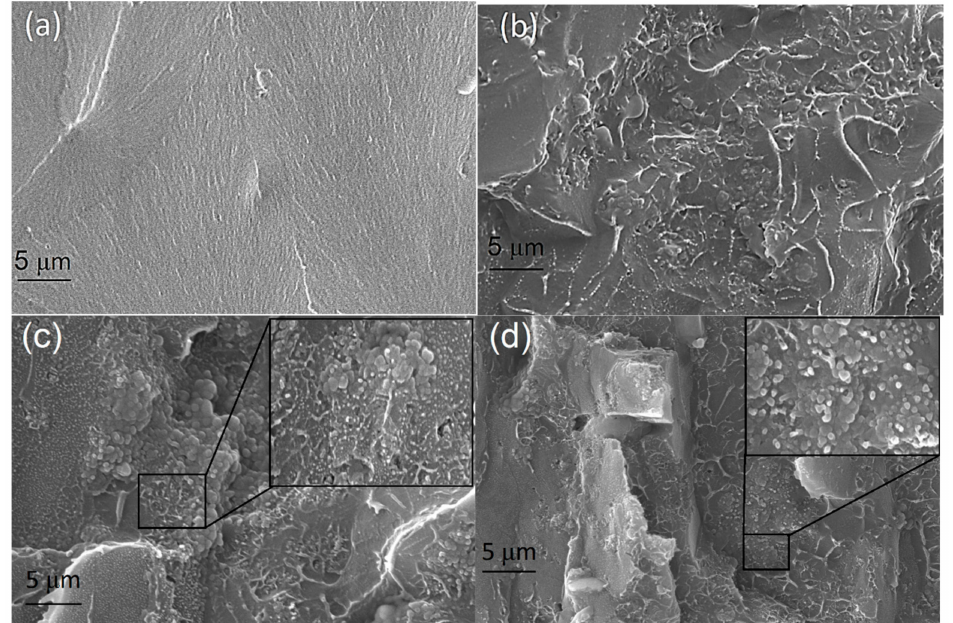
Figure 2. SEM micrographs of ( a ) polystyrene (PS), ( b ) PS / polyaniline (PANI)-5 wt %, ( c ) PS / PANI-5 wt % / MoS 2 -0.1 wt %, ( d ) PS / PANI-5 wt % / MoS 2 -1 wt %. The selected squared region is further zoomed in to show the dispersion of MoS 2 at 1 µ